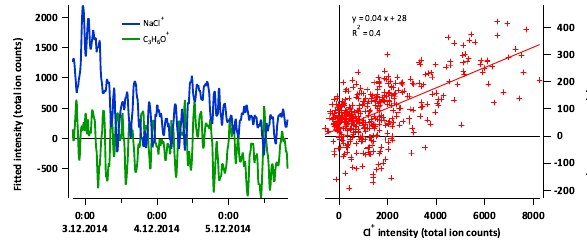
Figure 11. Left: time series (1h integration period) of the fit- ted intensities for the isobaric ions NaCl + ( m/Q = 57.96Th) and C 3 H 6 O + ( m/Q = 58.04Th). Right: correlation of the NaCl + ion signal with that of Cl + (10min integration